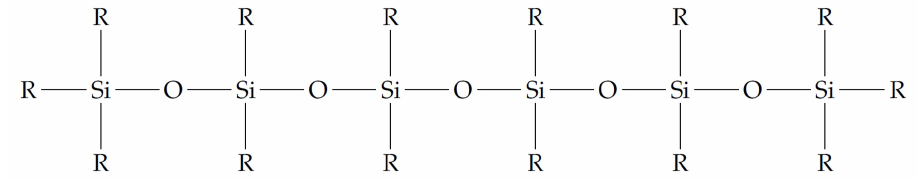
Figure 3. Silicon–oxygen backbone of silane polymers. R stands for a CH 3